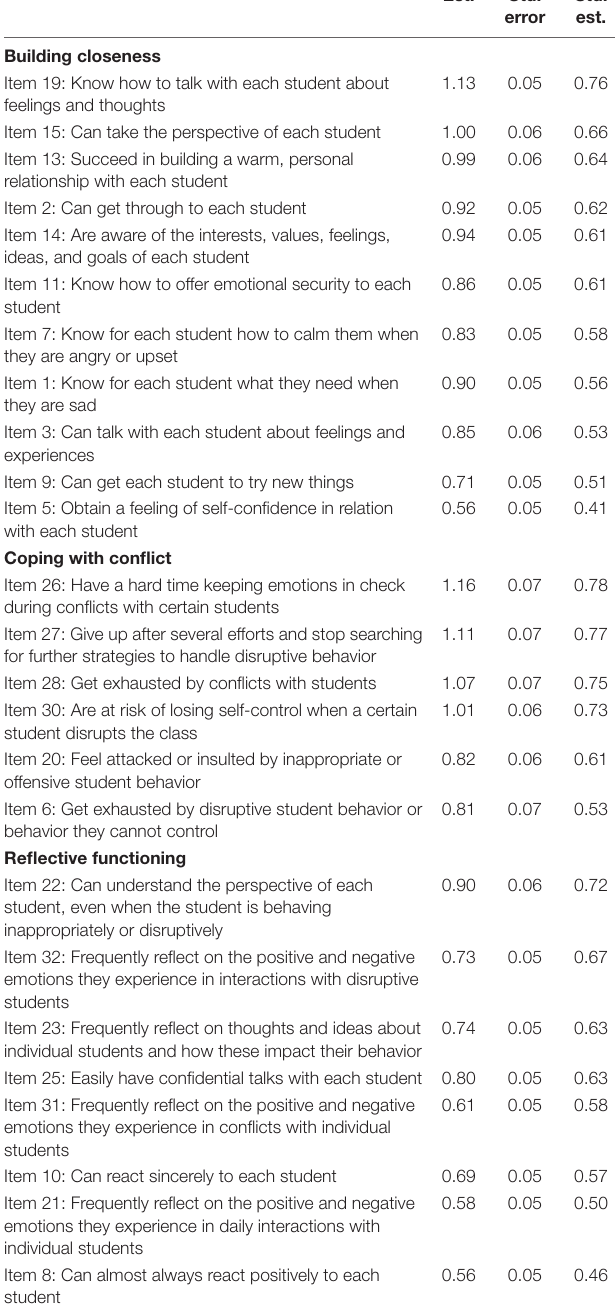
TABLE 8 | Results of confirmatory factor analysis for self-efficacy. Est. Std. Std. error est. Building closeness